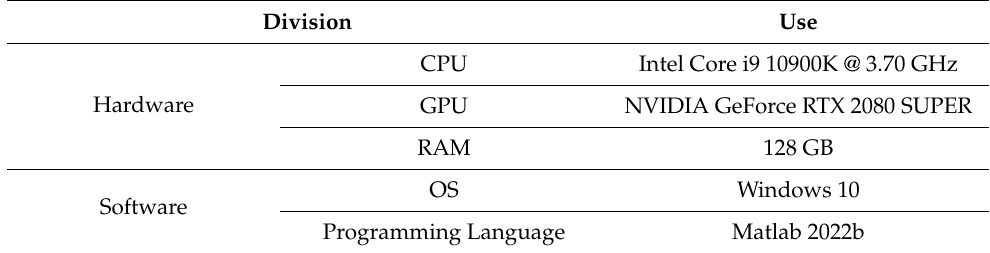
Table 1. Experimental environment.